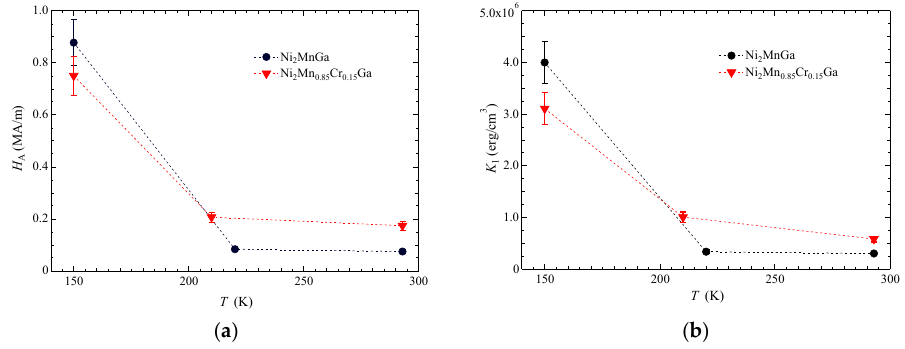
Figure 4. ( a ) The temperature dependence of the magnetic ‐ anisotropy field H A ; ( b ) The temperature dependence of the magnetic ‐ anisotropy energy K 1 . The error bars were indicated.